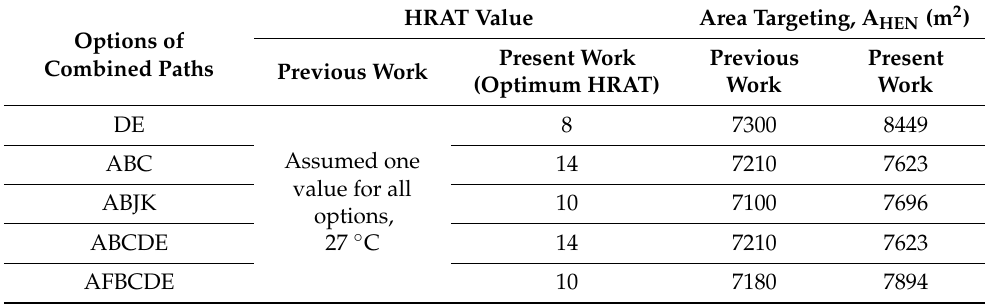
Table 5. Comparison between previous and present work for area targeting in a HEN.